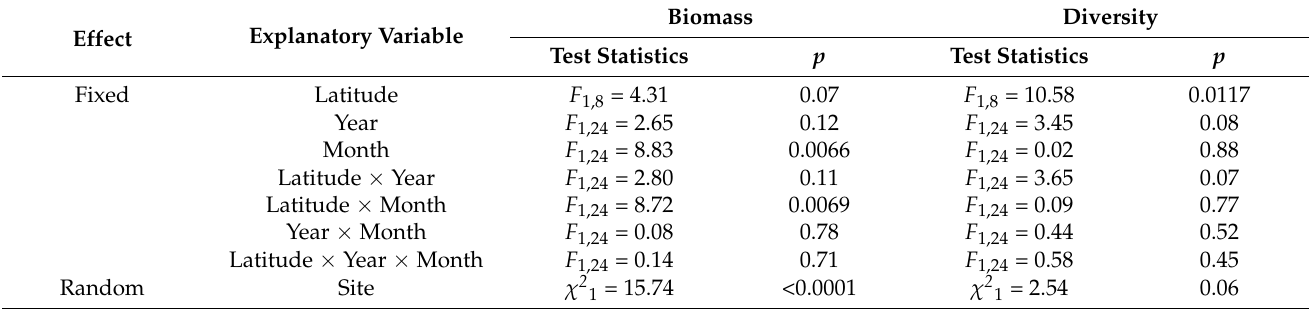
Table 2. Sources of variation in biomass and diversity (measured by Shannon H index) of soil macrofauna (SAS GLIMMIX procedure; mixed model ANCOVA, type III